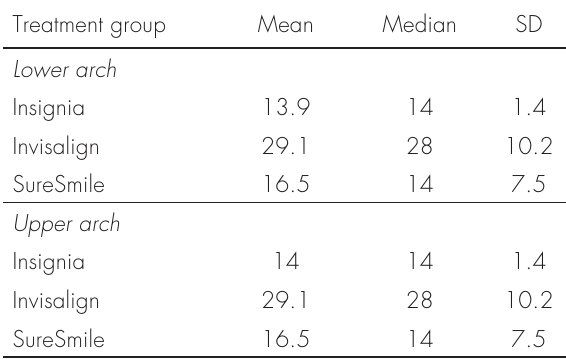
Table III. Lower and upper arch age distribution (years).